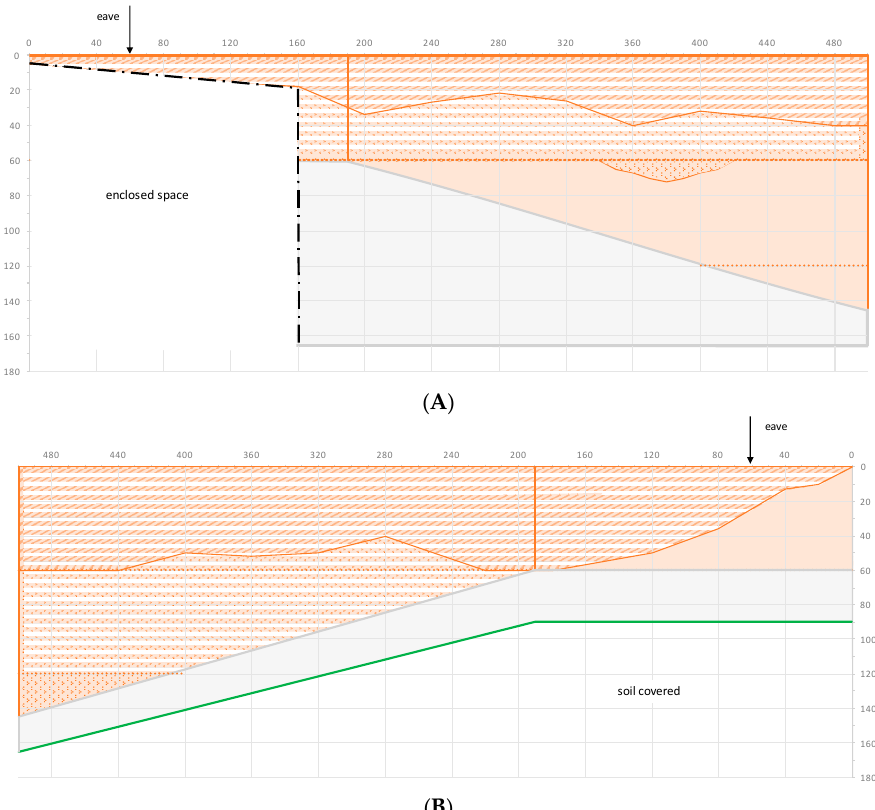
Figure 19. Schematic representation of the observed decay of wall 6: ( A ) eastern face; ( B ) western face. For the legend, see Figure 13.